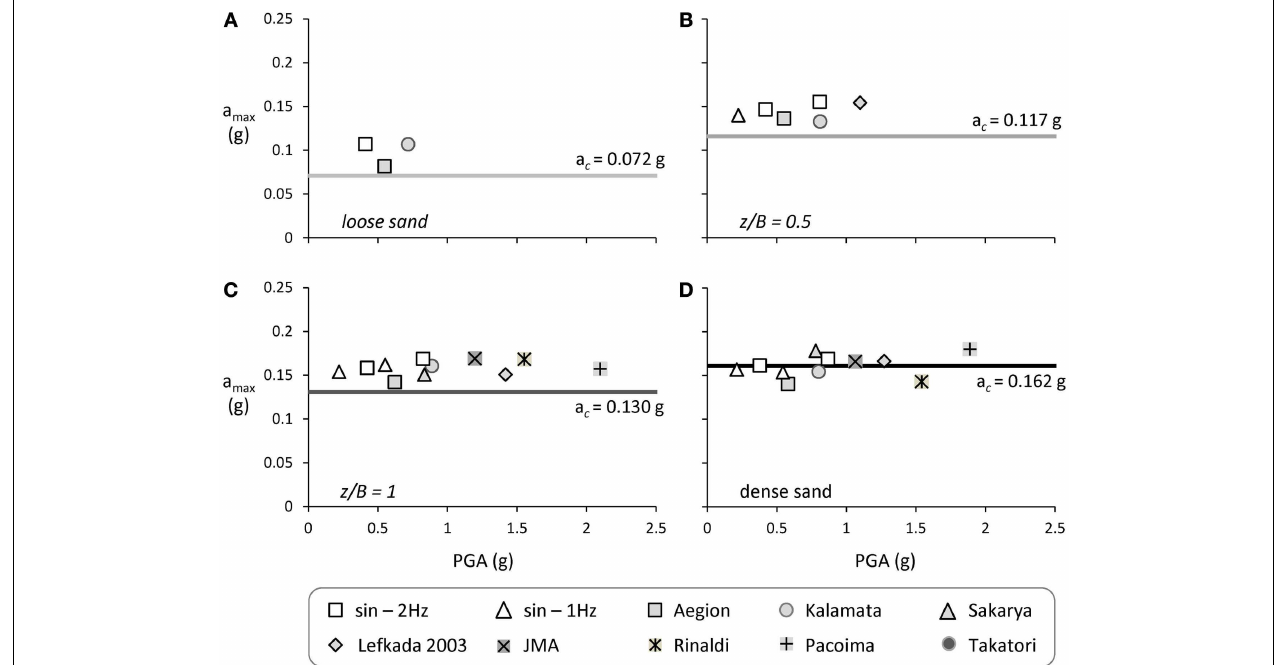
FIGURE 12 | Synopsis of the performance of the lightly loaded System A subjected to seismic shaking sequences I and II . Maximum acceleration a max at the oscillator mass as a function of PGA: (A) loose sand-poor soil conditions; (B) z/B = 0.5; (C) z/B = 1; and (D) dense sand-ideal soil